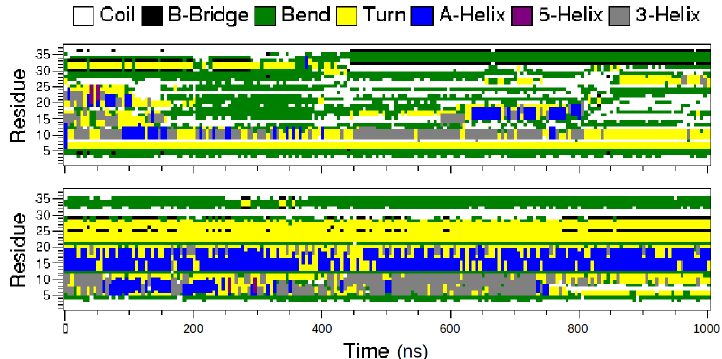
Figure 3. Time evolution of the secondary structures of the amidated ( top ) and non-amidated ( bottom ) hIAPP